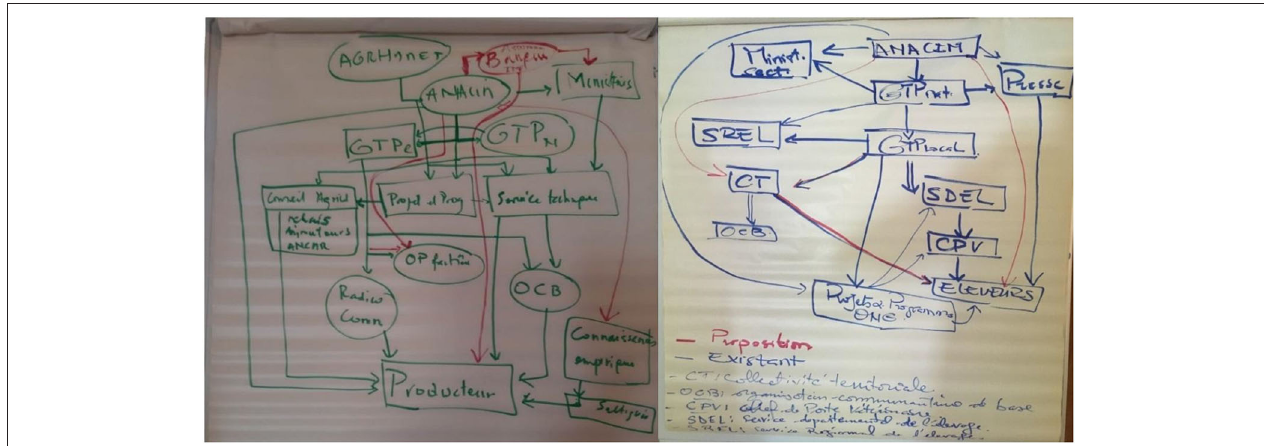
FIGURE 2 | Example of organization chart showing existing and missing links (red) for the agricultural sector (left) and livestock sector (right) produced by stakeholders in Senegal.